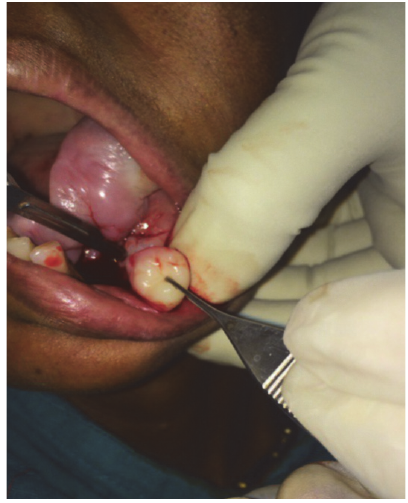
Figure 5: Incisional